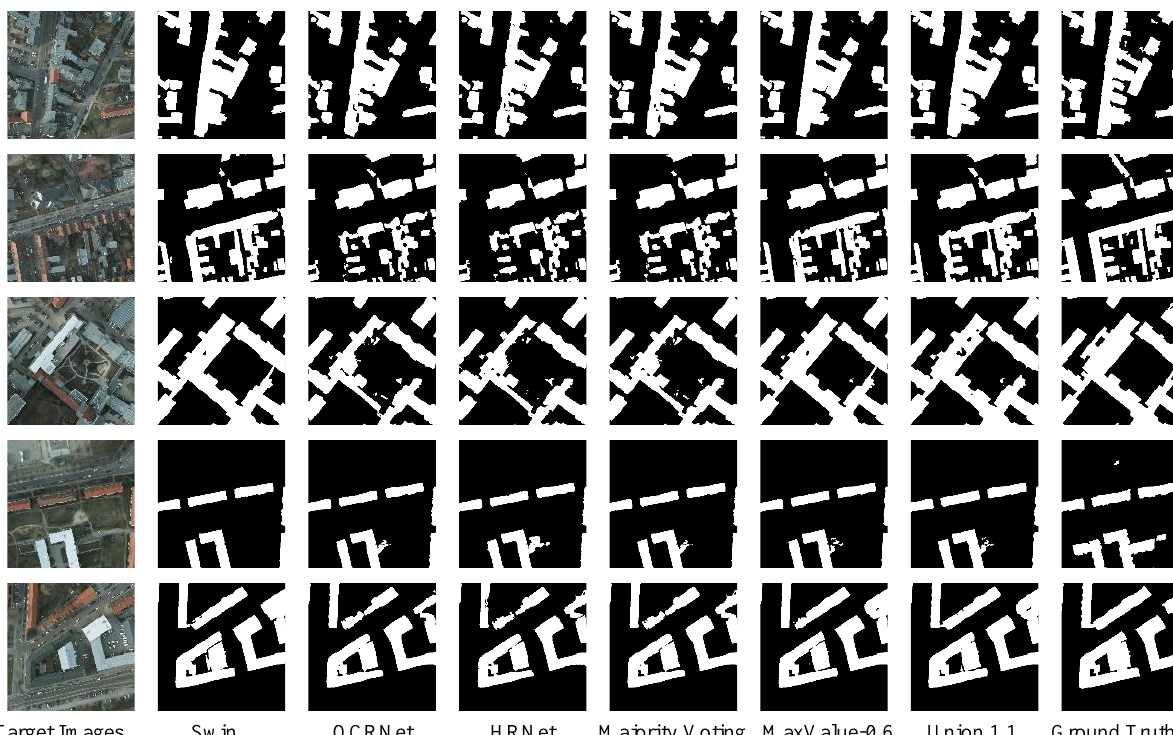
Figure.4 Examples of building extraction maps obtained by different methods for the Case 2